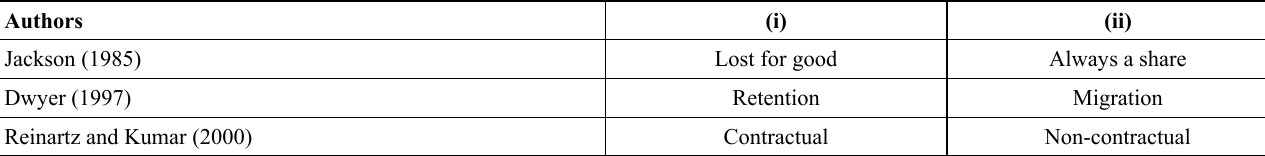
Table 5: Type of relationship between customer and